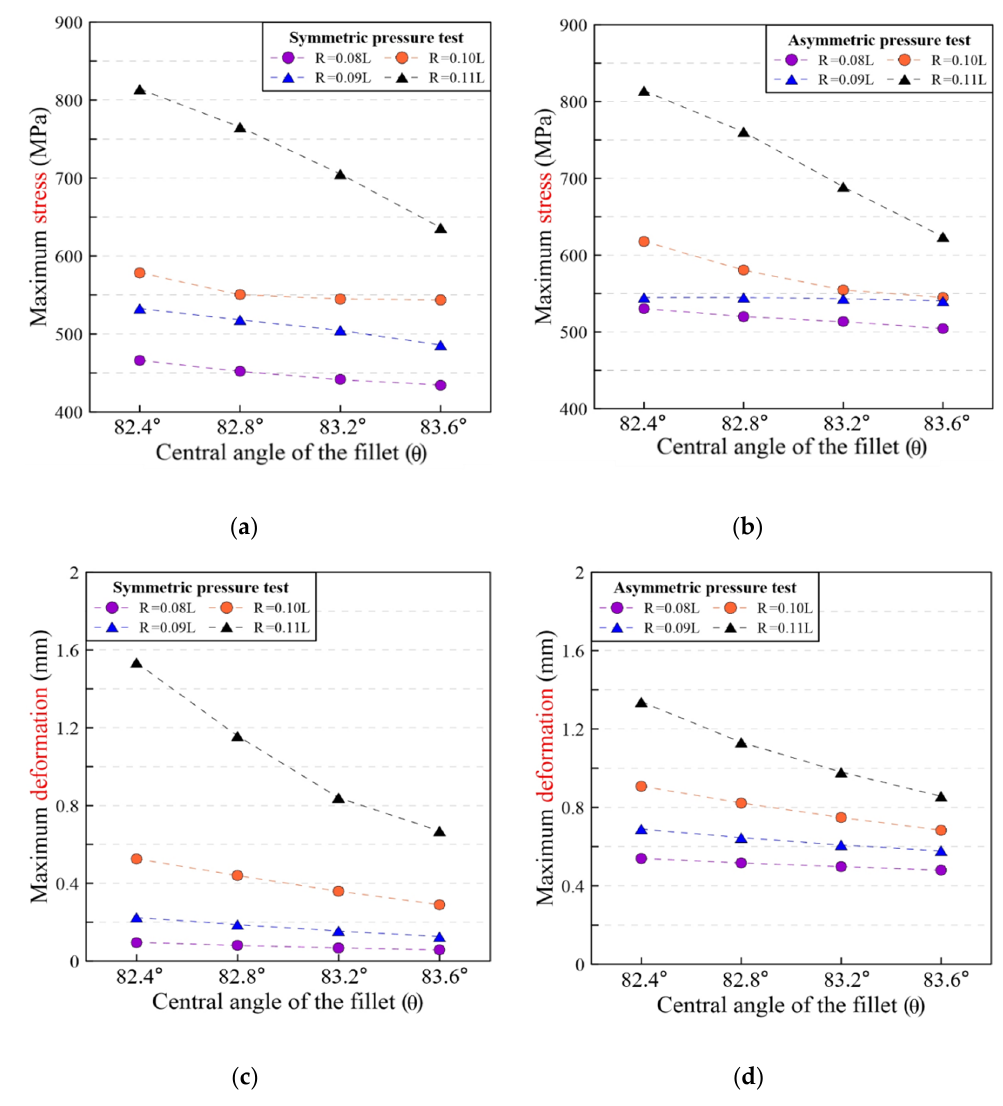
Figure 12. Maximum SPB stress and deformation according to the fillet angle in each test ( a , c ) symmetric pressure analysis and ( b , d ) asymmetric pressure analysis.